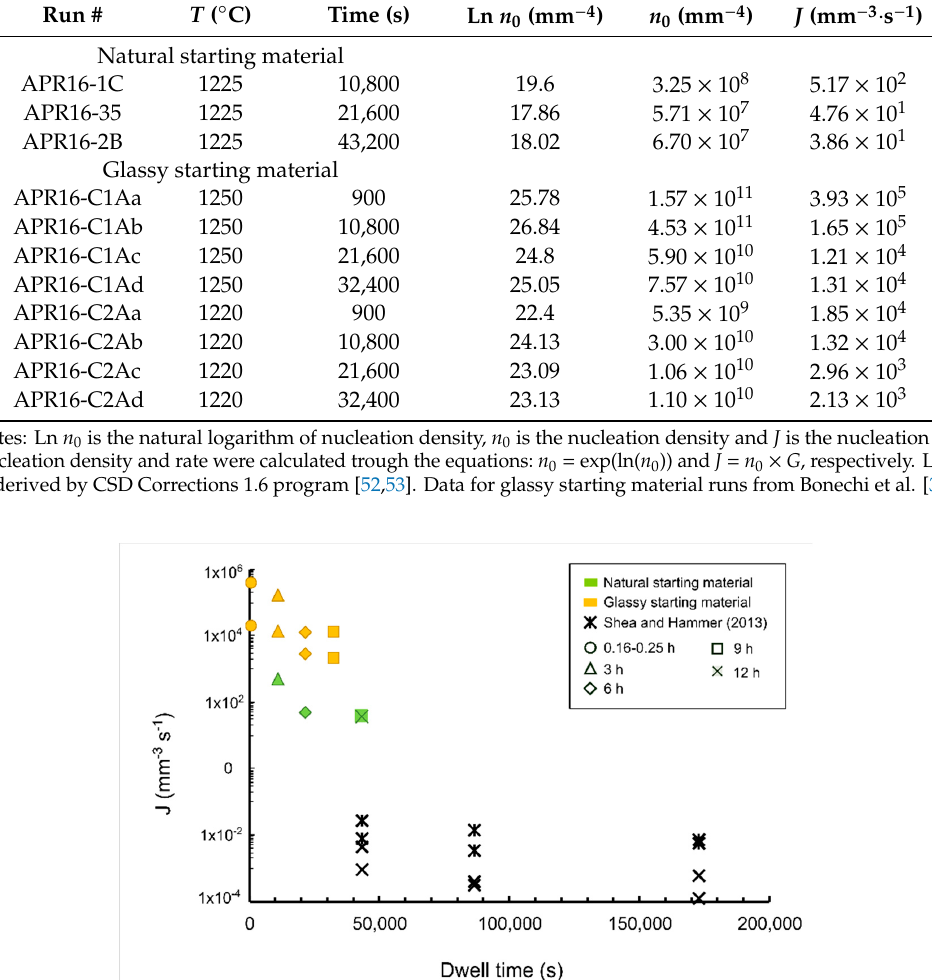
Figure 7. Variation of ( a – c ) the nucleation rate ( J ) with the undercooling ( Δ T eff ) and ( d ) the growth rate ( G L ) with the undercooling ( Δ T eff ). In Figure 7a are reported the runs of natural starting material series (in green), and glassy starting material series (in yellow); symbols are as in Figure 2. Figure 7b shows the single step cooling runs of Shea and Hammer [17] for comparison; colors indicate different duration of the runs: in red the 12 h ‐ runs, in purple the 24 h ‐ runs and in blue the 48 h ‐ runs. Figure 7c,d show the runs investigated in this study ( Δ T eff < 60 °C) and those of Bonechi et al. [31] ( Δ T eff > 60 °C); symbols are as in Figure 2. Dotted lines indicate the hypothetical variation of J with Δ T eff (Figure 7c) and of G with Δ T eff (Figure 7d). Green lines indicate runs obtained using natural starting material while black ones run obtained using vitrified starting material.